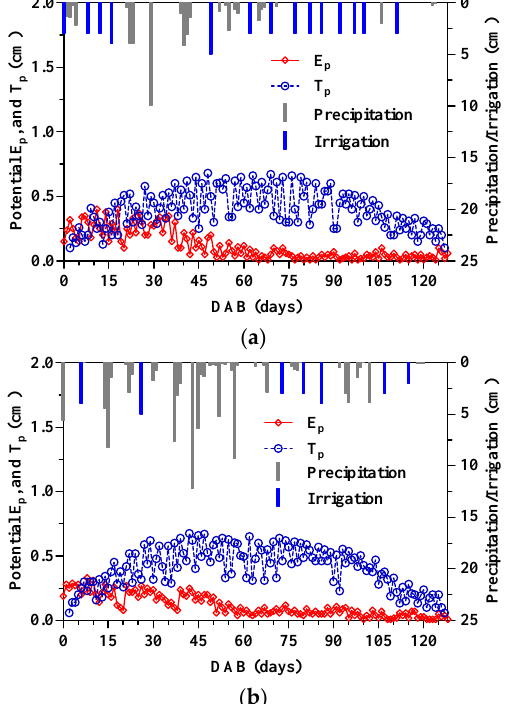
Figure 1. Potential evaporation, E P , potential transpiration, T P , precipitation and irrigation during the ( a ) 2008 and ( b ) 2009 seasons in the Taihu Lake Basin (DAB—days after basal fertilization).